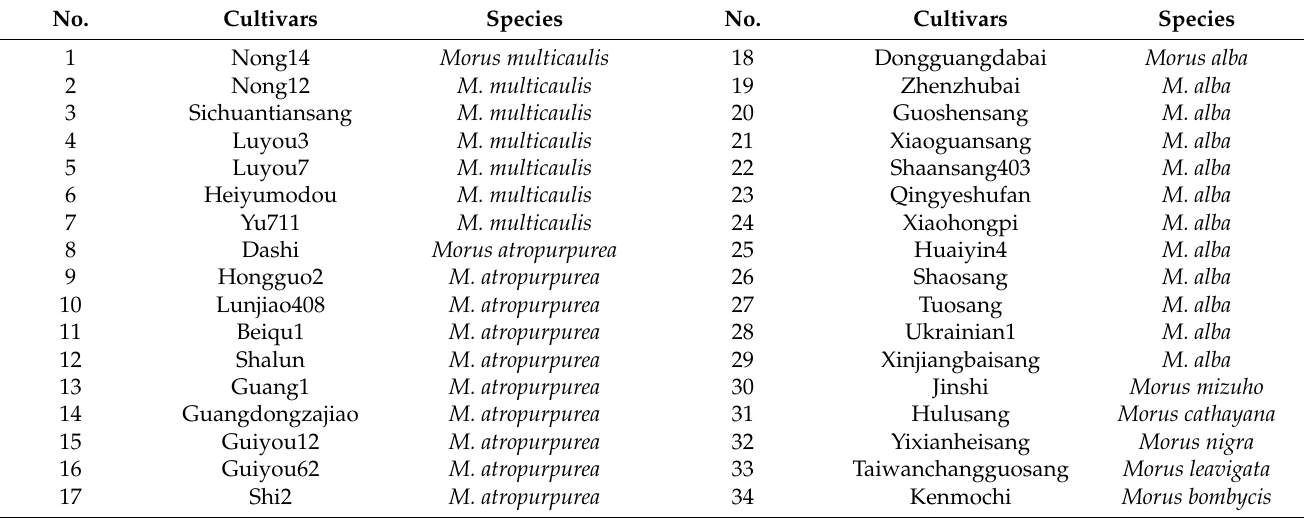
Figure 1. The principle of in-gel activity staining and detection of TI and CI activities in mulberry leaves. ( A ) Schematic diagram of in-gel activity staining of SPIs. Activity staining of TIs ( B ) and CIs ( C ) from leaves of mulberry variety Guang1. “TI” and “CI” represent trypsin inhibitor and chymotrypsin inhibitor, respectively. The arrows show activity-stained bands of protease inhibitors. Table 1. Mulberry varieties used in the